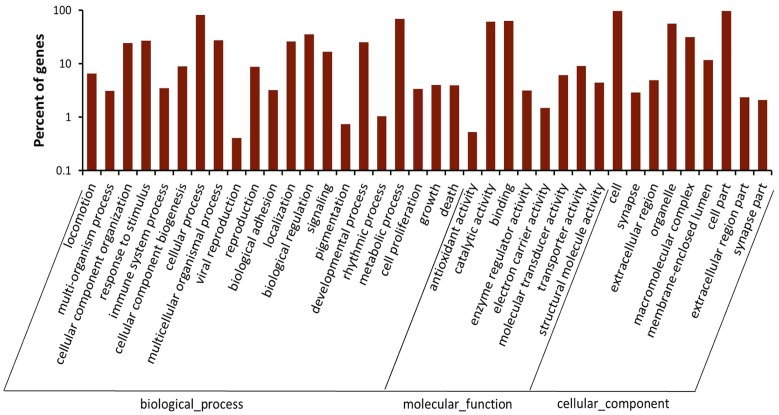
Gene ontology classification of the beet armyworm transcriptome.Blast2GO was used to analyze the 18,592 contigs identified by Blastx as having significant homology to genes in the NCBI nr database. “Cellular process” and “metabolic process” in biological process, “catalytic activity” and “binding” in molecular function, “cell” and “cell part” in cellular component were the most abundant.